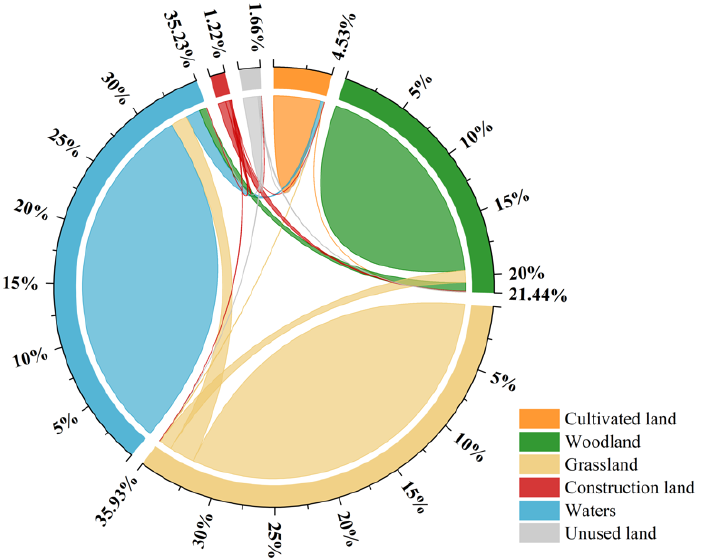
Figure 12. Transfer matrix of land use types in the upper Yangtze River from 1980 to 2018.